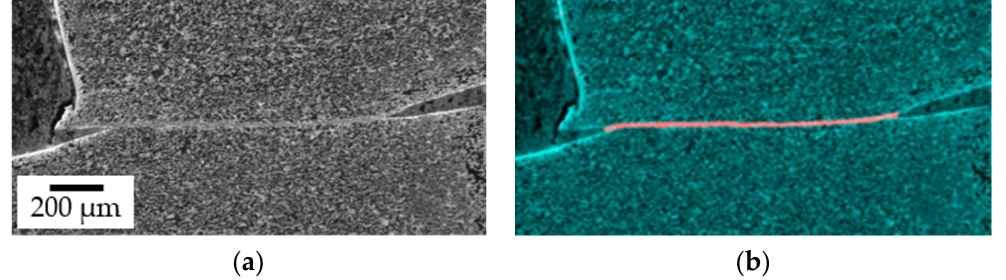
Figure 13. ( a ) Segmentation result and ( b ) prediction of the shear band by the network, shown in red.